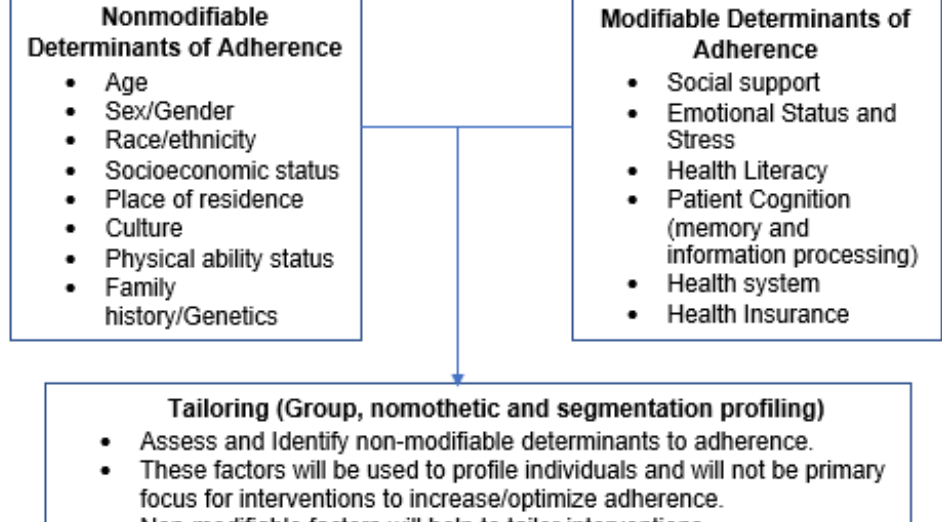
Figure 1. Workflow and framework to incorporate nonmodifiable and modifiable factors to improve and optimize health-related adherence